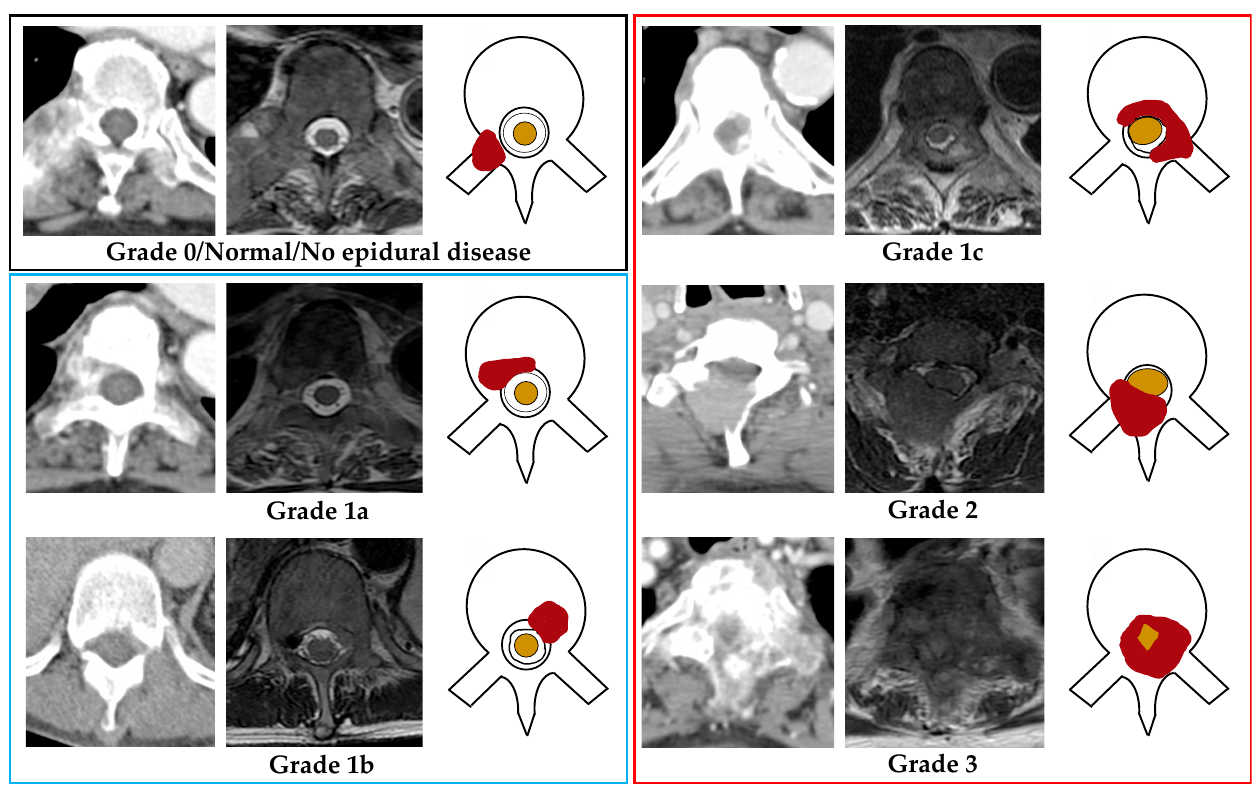
Figure 1. Bilsky grading for metastatic epidural spinal cord compression (MESCC) was demonstrated using axial CT, MRI (T2-weighted), and a picture for each grade (right to left). The red shaded region shows MESCC in each image. Grade 0/normal (Black outline): No metastatic epidural disease present. Low-grade MESCC (Blue outline); Grade 1a: Metastatic epidural soft tissue with no thecal sac deformity, or Grade 1b: Metastatic epidural soft tissue with thecal sac deformity but no spinal cord contact. High-grade MESCC (Red outline); Grade 1c: Metastatic epidural soft tissue touching the spinal cord with no discernible compression or displacement, or Grade 2: Metastatic epidural soft tissue cord compression with some surrounding cerebrospinal fluid still visible, or Grade 3: Metastatic epidural spinal cord compression without discernible surrounding cerebrospinal fluid. Thecal sac = black outline within the spinal canal, Spinal cord = Yellow shaded area within the spinal